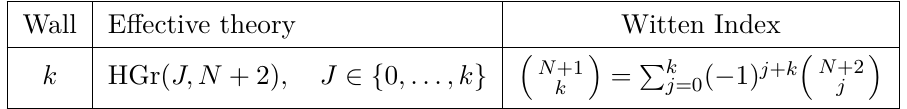
Table 4 . IR models on the vacuum structure of (4.16) for m < 0 and k ≤ N +1 contributions to the Witten index are